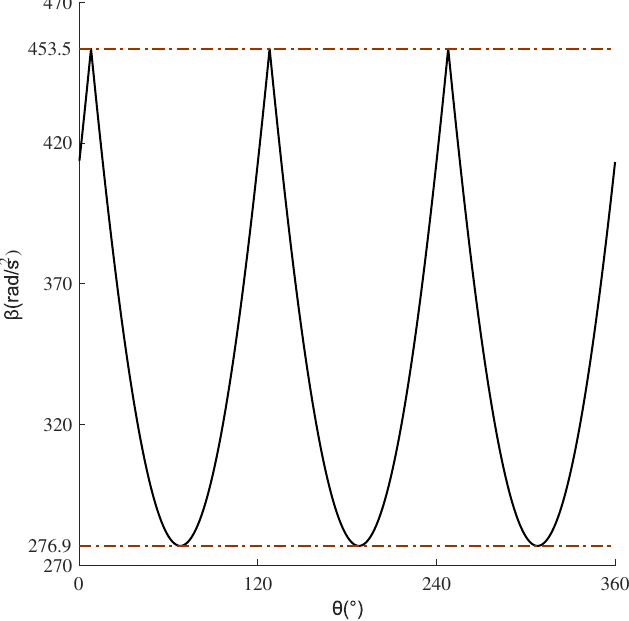
Figure 6. Maximum angular acceleration—orientation